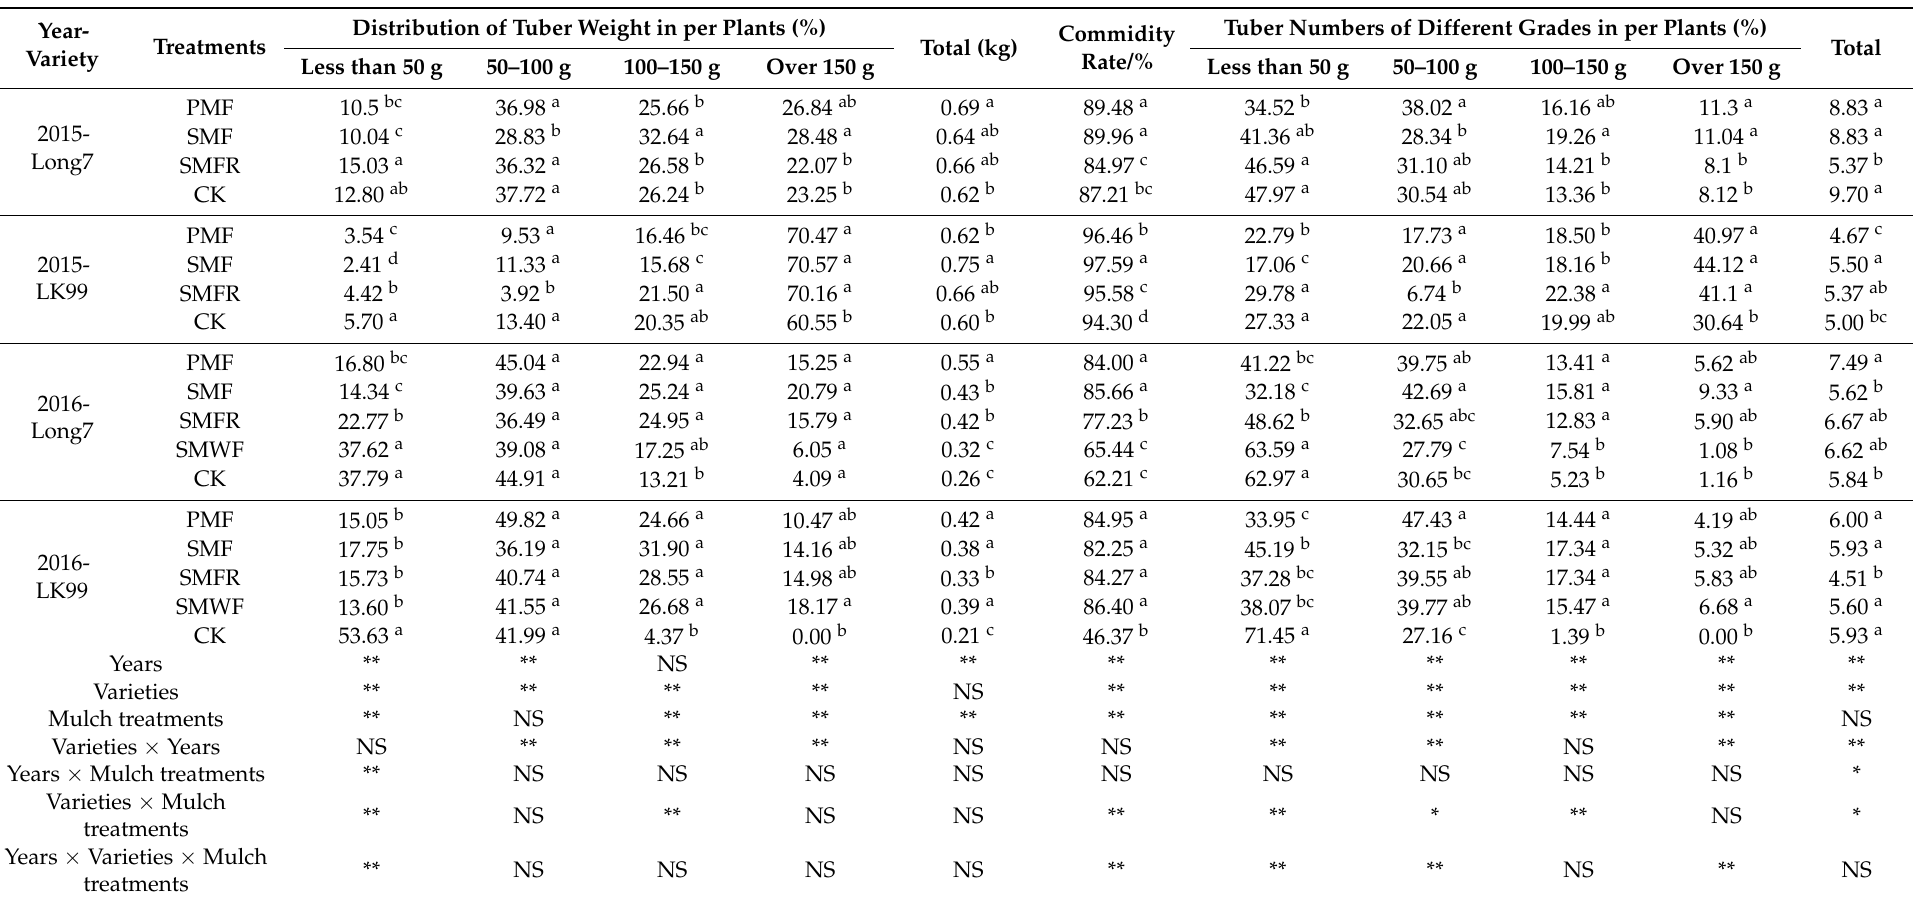
Table 2. Potato tuber grades and weight of per plants under different mulching patterns in 2015 and 2016 in Dongwei, northwest